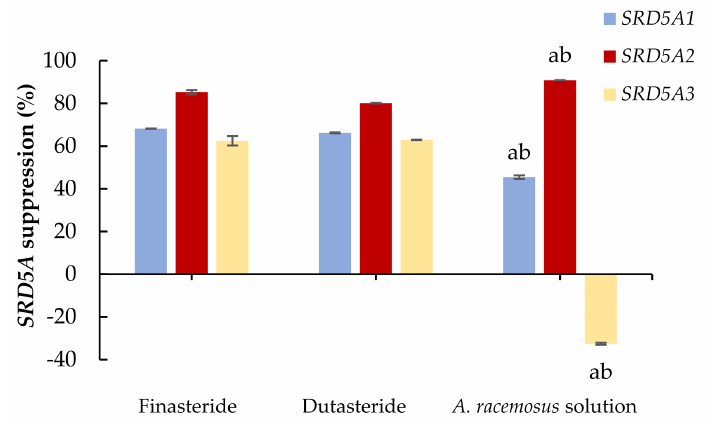
Figure 1. The effects of 0.1 mg/mL of finasteride and dutasteride, and 0.5 mg/mL of A. racemosus Willd. root extract solution on 5-alpha reductase isoenzymes expression ( SRD5A ) in human prostate cancer cells. The percentage of SRD5A suppression was compared with the control. Statistical significance in comparison to finasteride and dutasteride is indicated as “a” and “b”, respectively ( p <